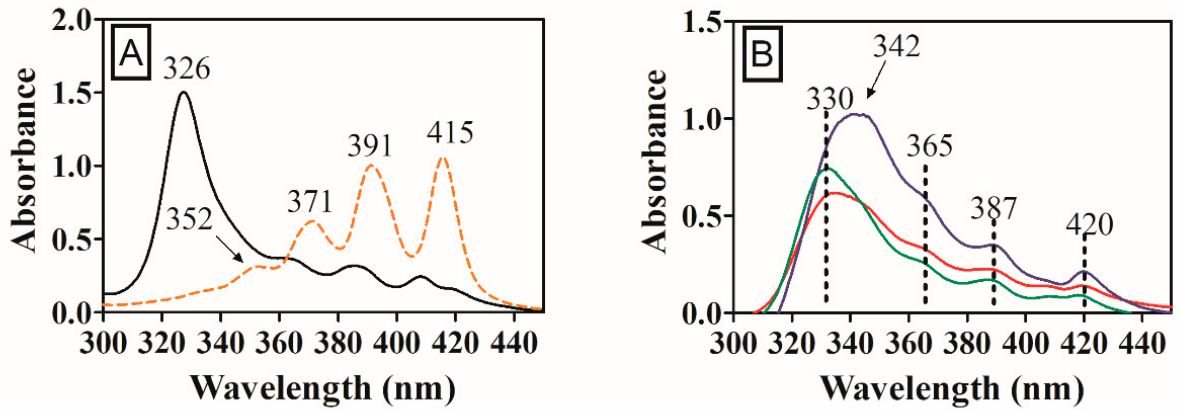
Figure 6. UV/Vis spectra of ( A ) commercial AmB (aqueous solution plus surfactant) (black line) and AmB in DMSO (orange line), and ( B ) AmB-loaded acylated nanoparticle aqueous solution CGAc AmB (red line); CGProp AmB (blue line); CGBut AmB (green line).